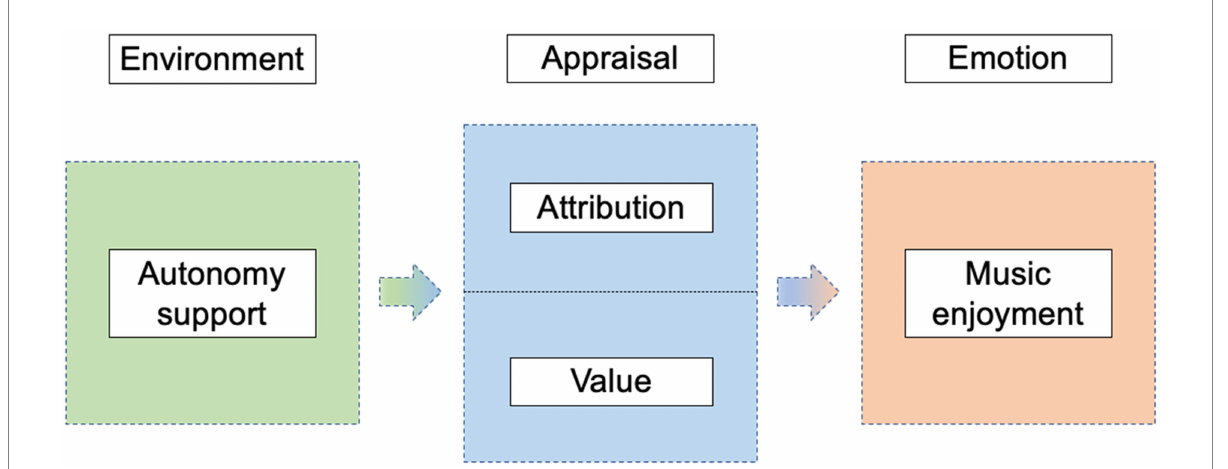
FIGURE 1 Mediation model of attributions between autonomy support and music